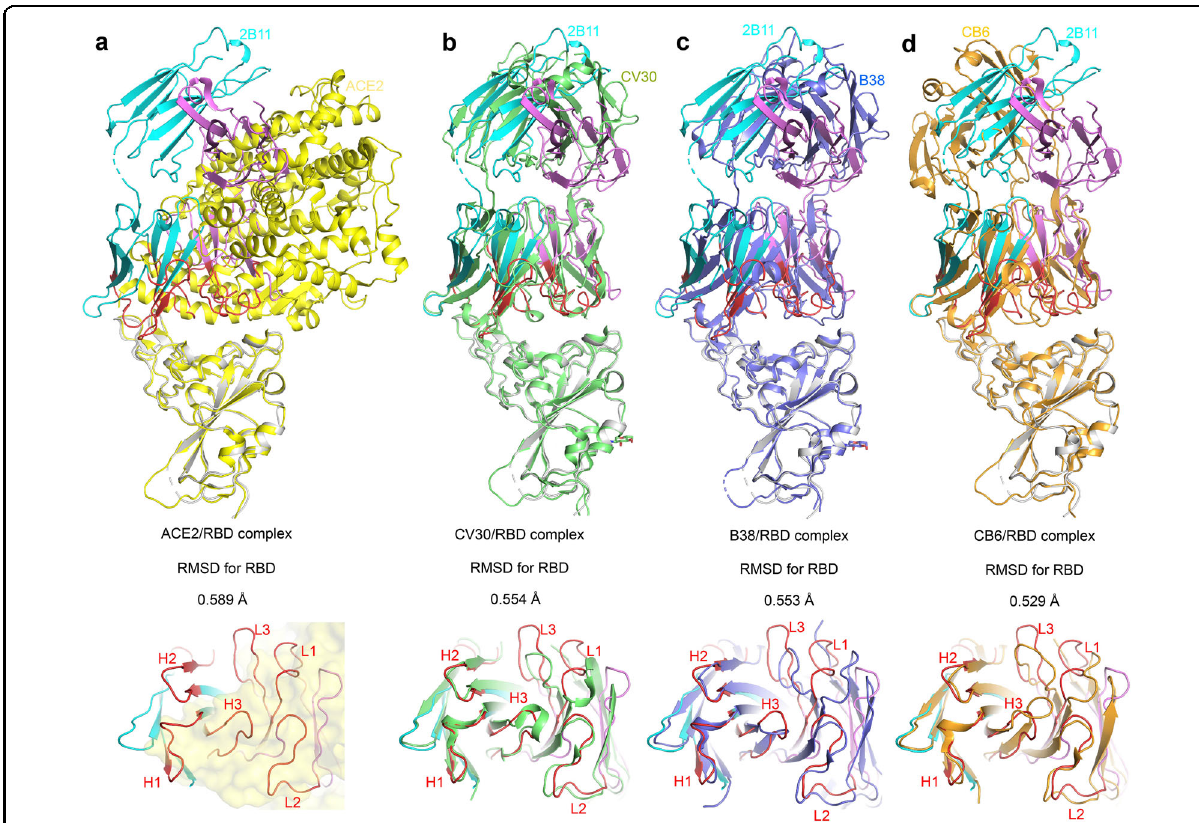
Fig. 5 Comparison of the complexes between RBD and ACE2, or the 2B11-Fab, or other IGHV 3-53/ IGHV 3-66 germline-derived neutralizing antibodies. a Structural alignment between the ACE2/RBD and 2B11/RBD complexes. The ACE2/RBD complex is shown in yellow. The image below is the bottom view of the main image without the RBD. b Structural alignment between the 2B11/RBD and CV30/RBD complexes. The CV30/RBD complex is shown in green. c Structural alignment between the 2B11/RBD and B38/RBD complexes. The B38/RBD complex is shown in light blue. d Structural alignment between the 2B11/RBD and CB6/RBD complexes. The CB6/RBD complex is shown in